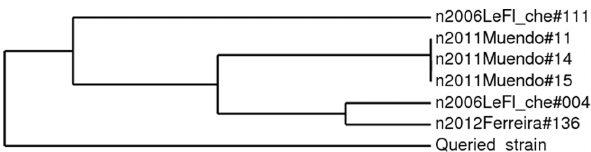
Figure 2. Clustering analysis of a field strain of Brucellaabortus 3 from Niger (Queried_Strain) with field and reference strains in the Brucella multiple loci variable number tandem repeats analysis (MLVA) database (MVLABANK, 2012) using panels 1 and 2. The data are given in columns from left to right: year of isolation and